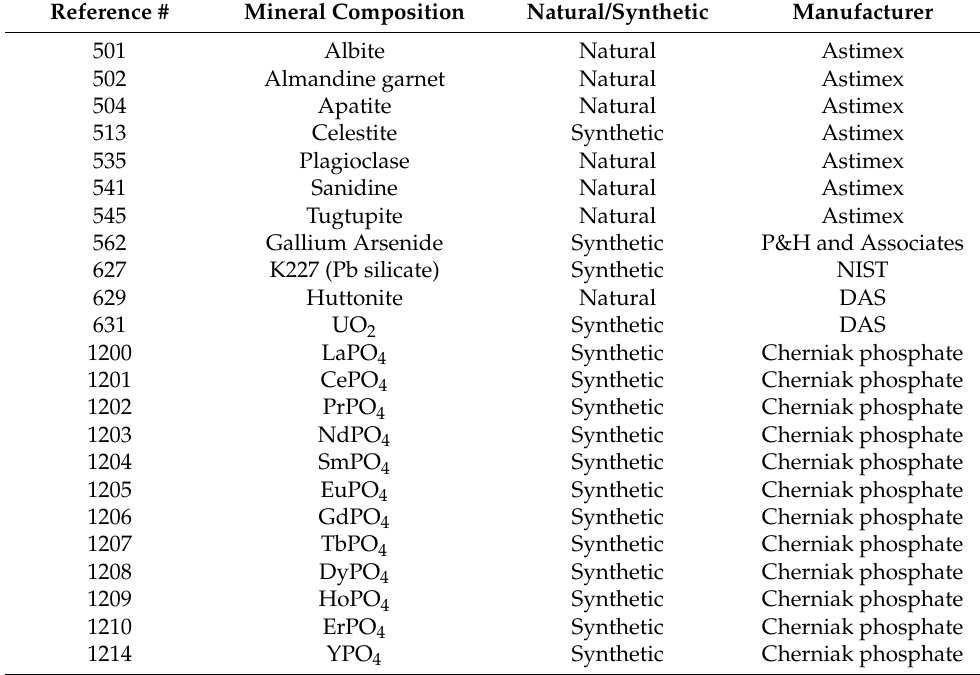
Table A2. Primary and interference standard information.